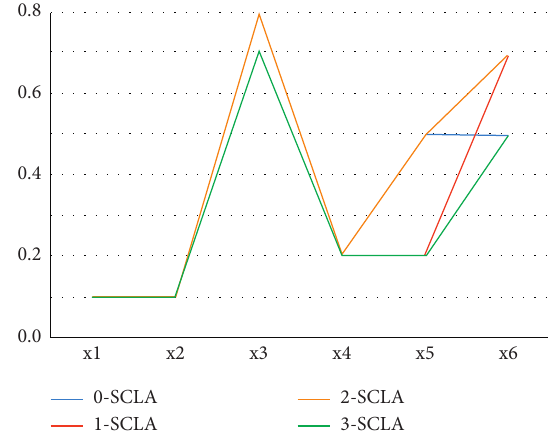
Figure 1: The representations of the four types of SCLA models.